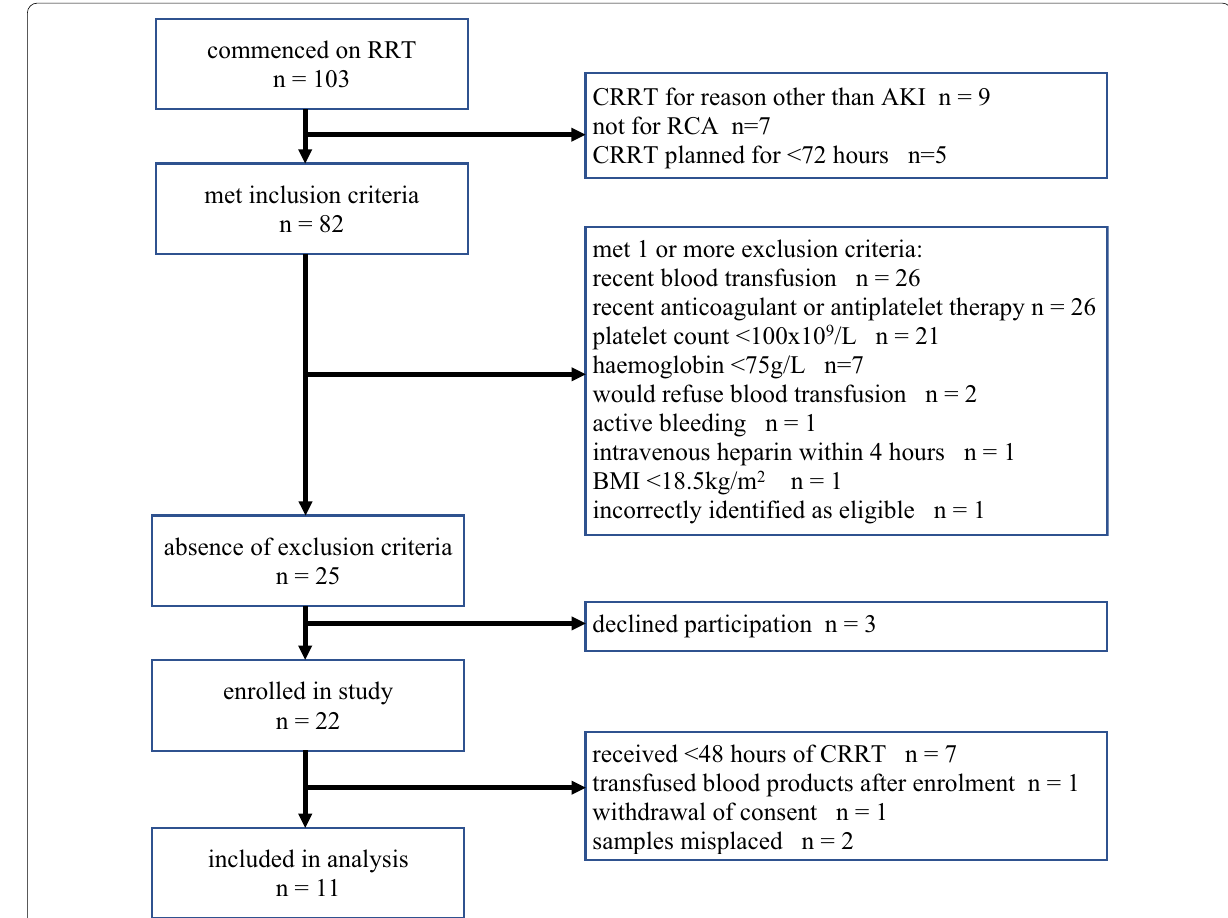
Fig. 1 Cohort selection flowchart. BMI body mass index, CRRT continuous renal replacement therapy, RCA regional citrate